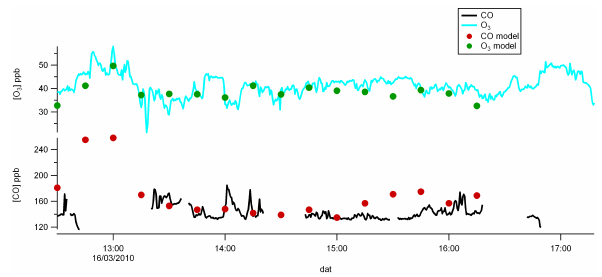
Fig. 9. Ozone and CO concentration time series from flight B518 with back trajectory modelled